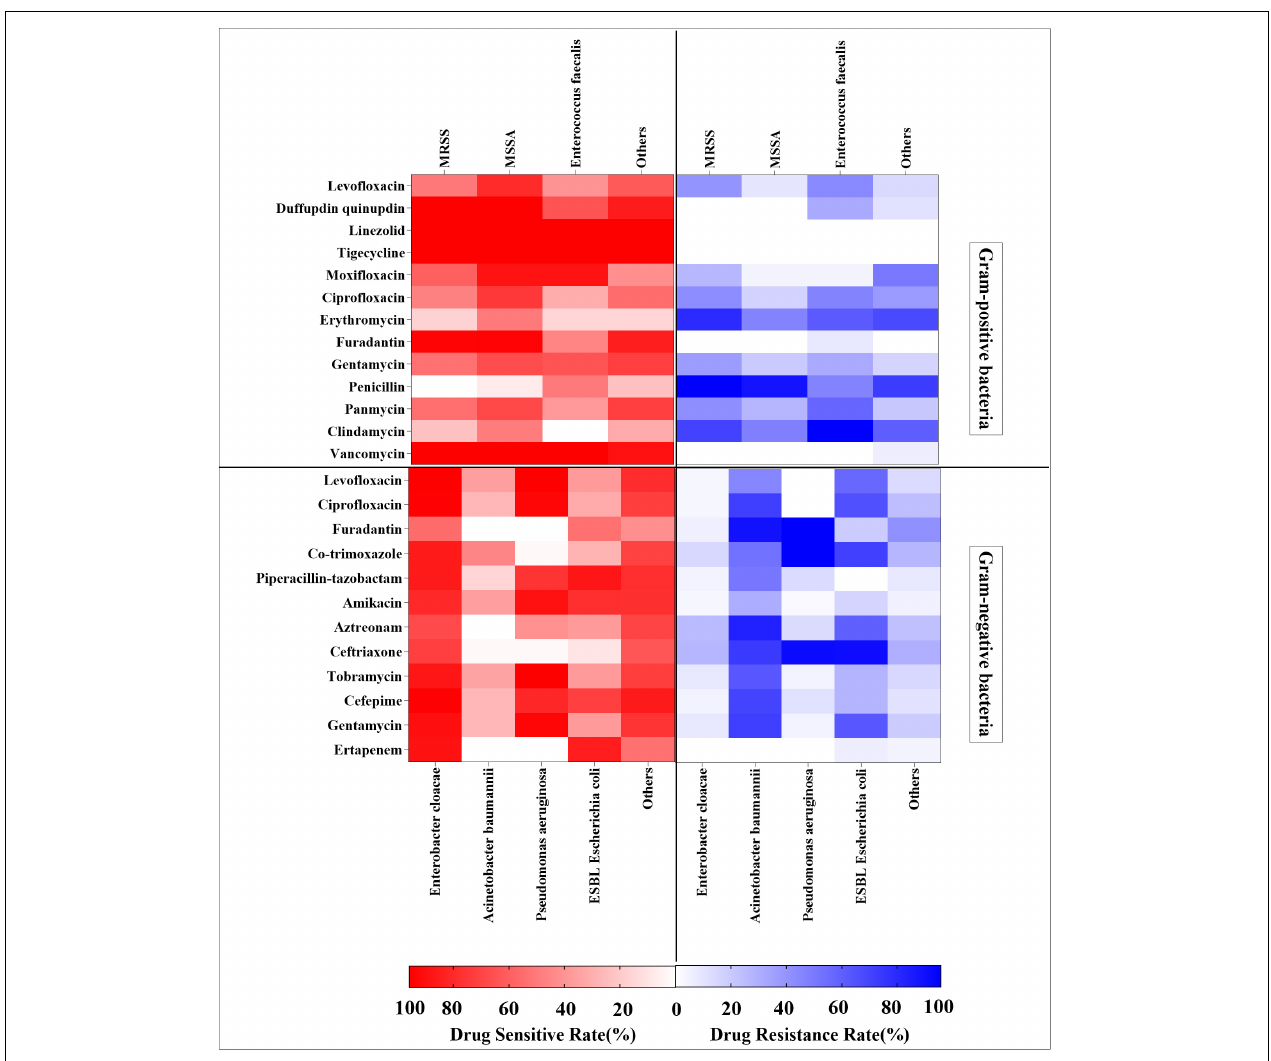
FIGURE 6 | Heat map showing drug resistance rates and sensitivity rates analysis of Gram-positive bacteria and Gram-negative